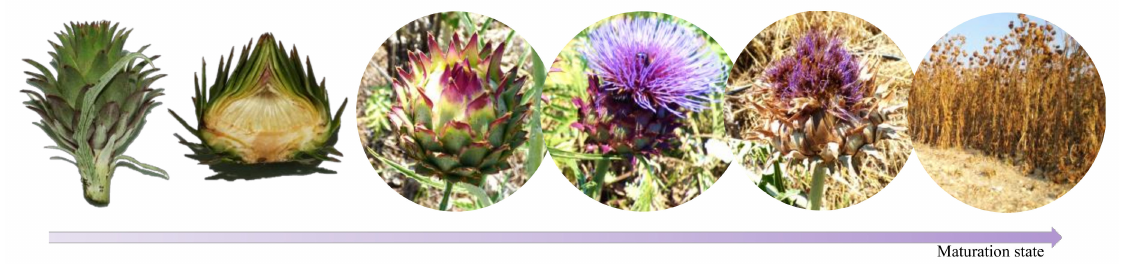
Figure 1. Evolution of maturity (Car A to F from left to right) of Cynara cardunculus L. heads during the growing